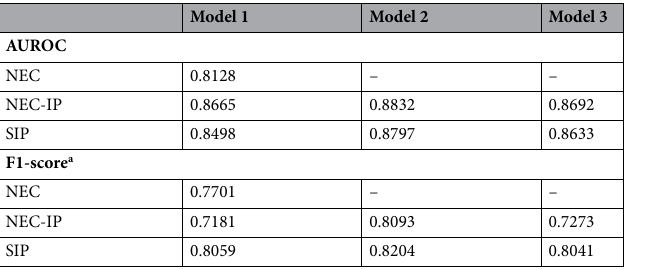
Table 3. Performance of the proposed ANN models in predicting NEC, NEC-IP, and SIP. ANN artificial neural network, NEC necrotizing enterocolitis, NEC-IP intestinal perforation associated with necrotizing